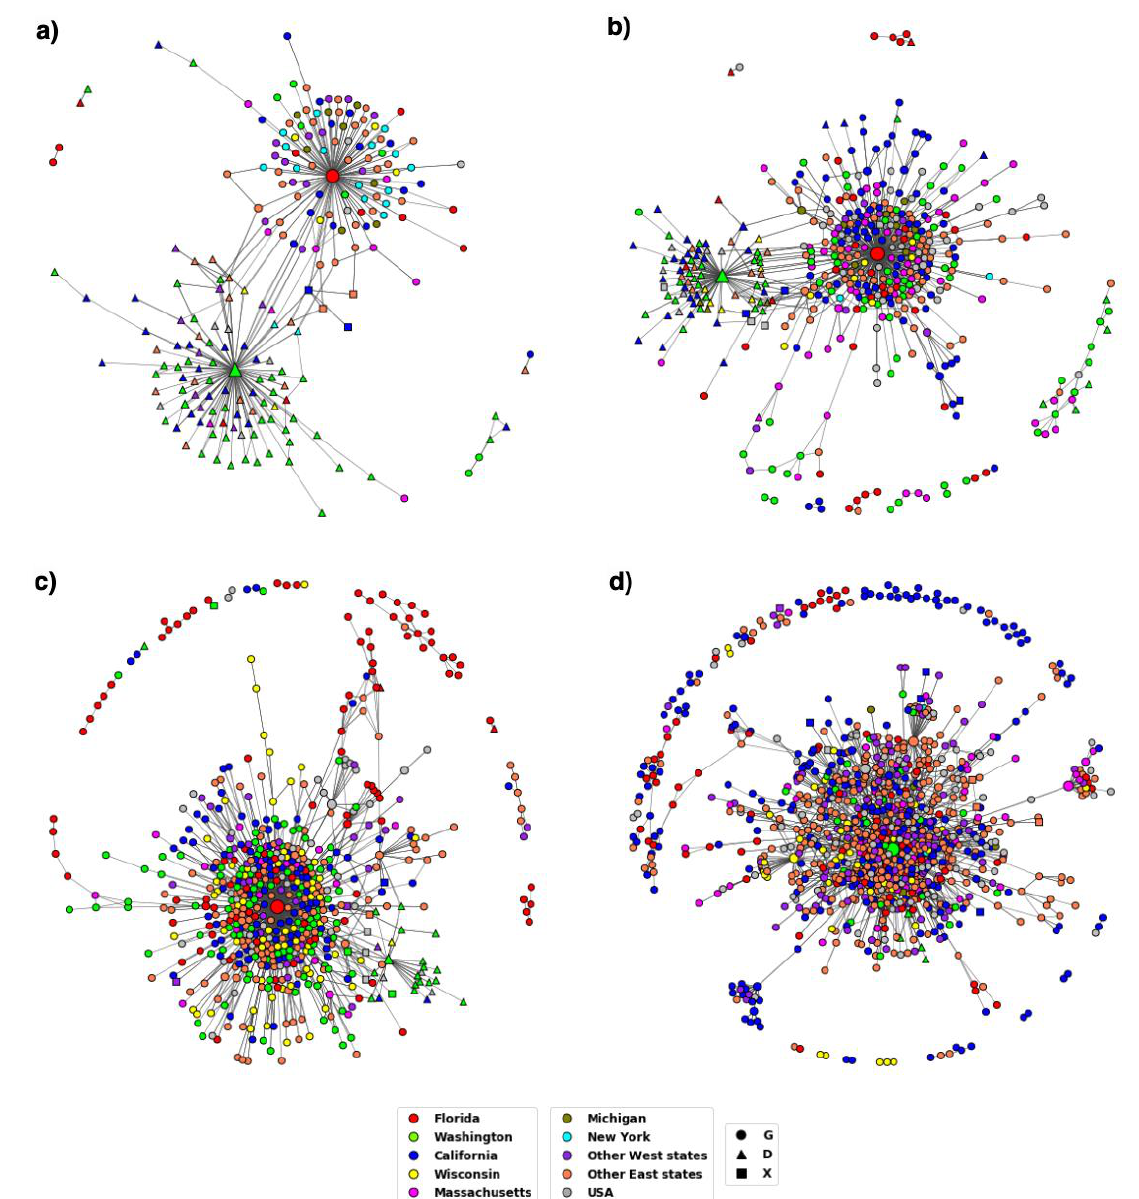
Figure 2. DiWANN networks for the first four time periods T1–T4. ( a ) The network for T1 comprised of 221 nodes, ( b ) T2 comprised of 456 nodes, ( c ) T3 comprised of 622 nodes, ( d ) T4 comprised of 1035 nodes. The shape of the nodes corresponds to the aa at residue 614 and the node color to the location as depicted by the legend . Nodes labelled as ‘USA’ did not have location information.